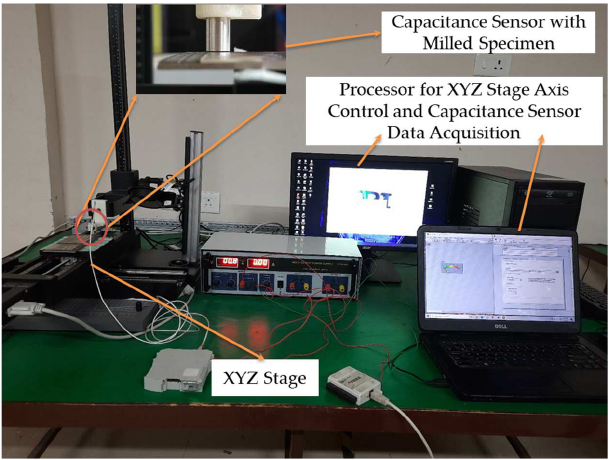
Figure 6. Micromovement gantry setup for roughness measurement using capacitance sensor. Table 1. Specification of roughness measurement setup using capacitance sensor.